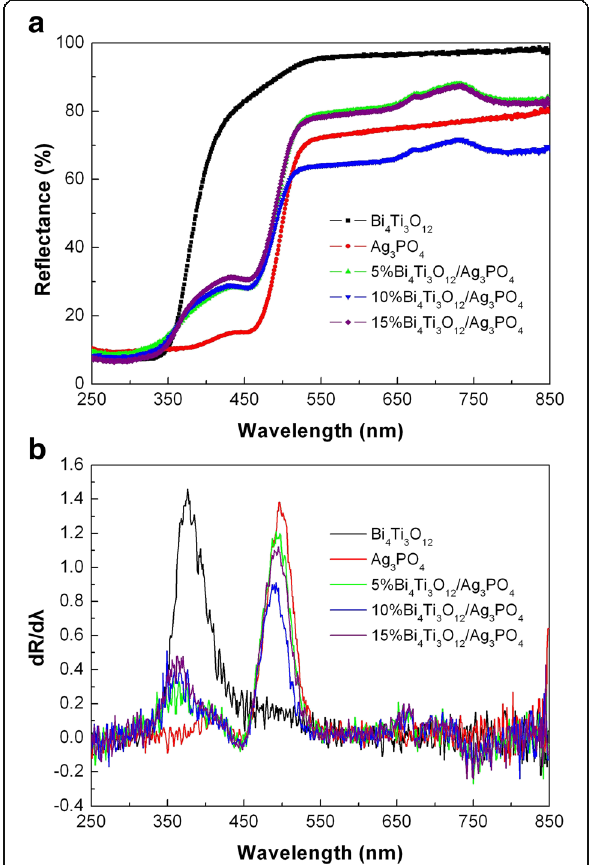
Fig. 6 a UV-vis DRS spectra of Bi 4 Ti 3 O 12 , Ag 3 PO 4 , and Bi 4 Ti 3 O 12 / Ag 3 PO 4 composites. b The corresponding first derivative spectra